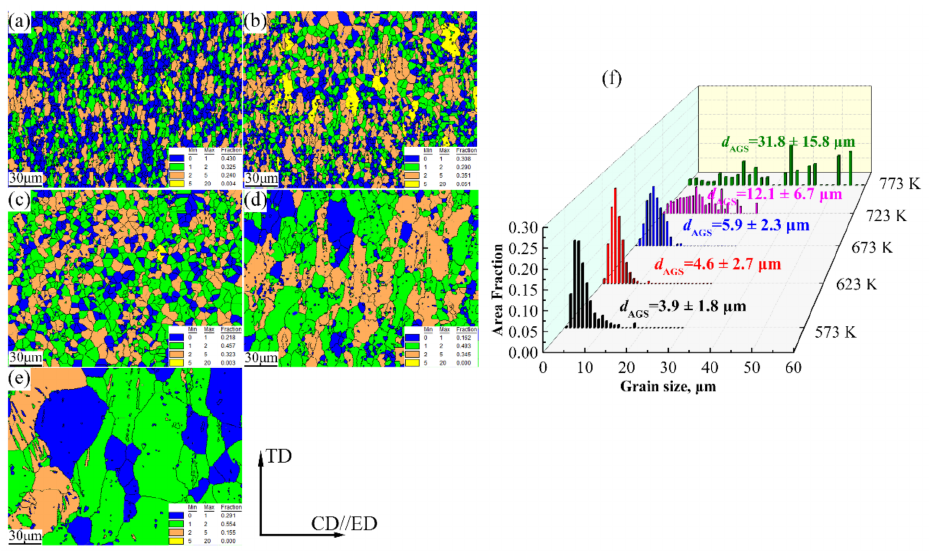
Figure 11. GOS maps of the Mg-2.5Nd-0.5Zn-0.5Zr alloy deformed at different temperatures and a strain rate of 0.001 s − 1 , ( a ) 573 K, ( b ) 623 K, ( c ) 673 K, ( d ) 723 K, ( e ) 773 K and ( f ) grain size distribution. (ED: extrusion direction, CD: compression direction, TD: transverse